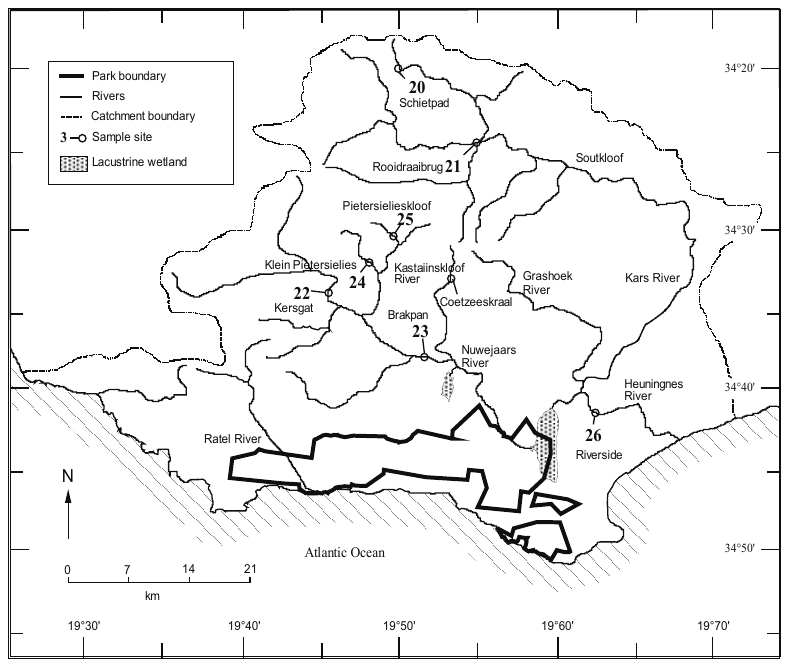
Fig. 2. Map of the Heuningnes catchment showing fish survey sites of the River Health